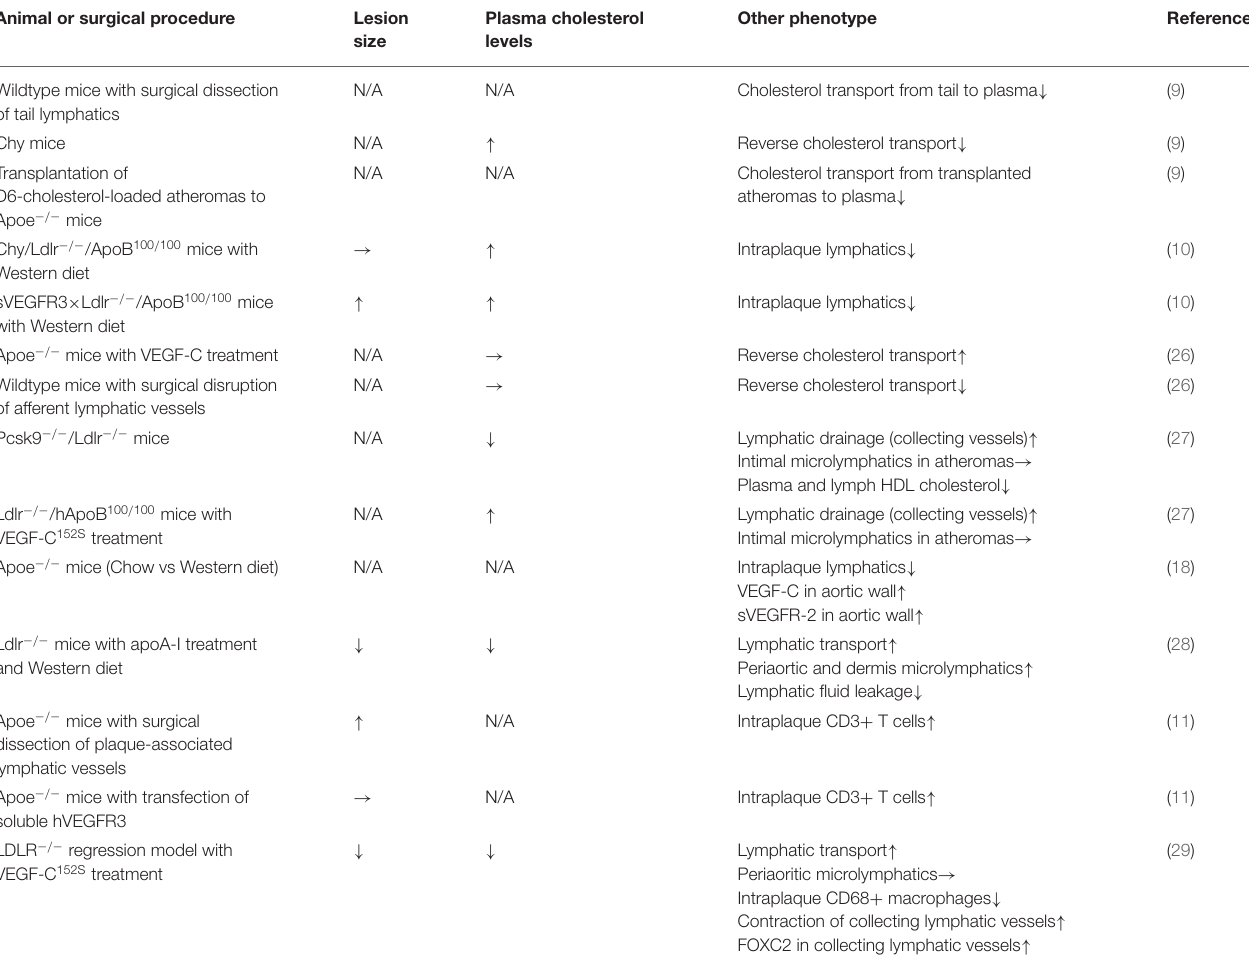
TABLE 1 | Lymphatic function-related assessment and atherosclerosis-related phenotypes in normocholesterolemic and hypercholesterolemic animal